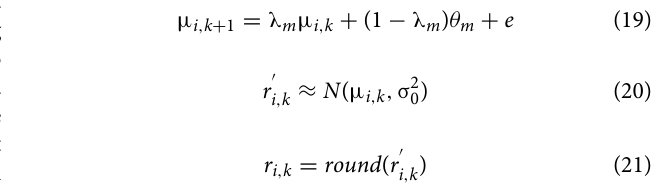
Frontiers in Neuroscience |